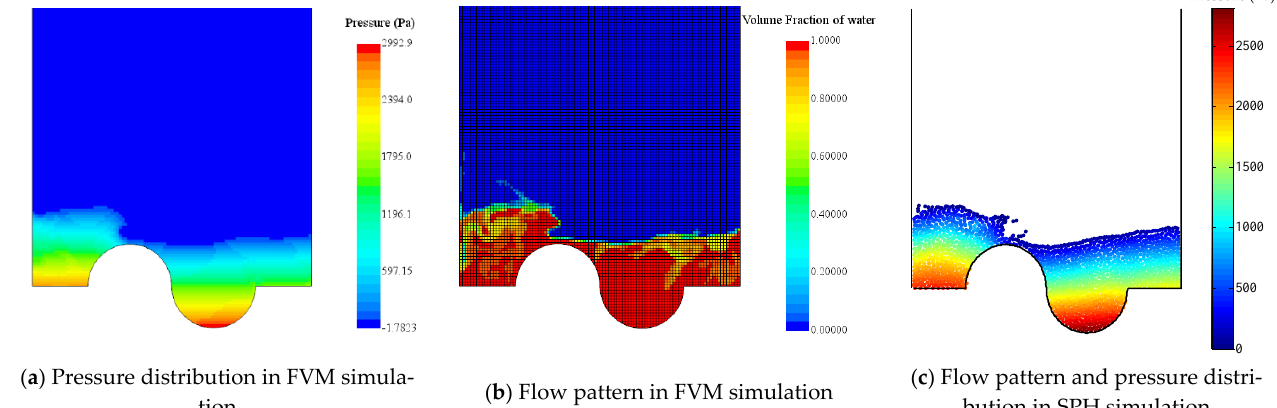
Figure 11. Comparisons of the flow pattern and pressure distribution at 10.0 s: ( a ) Pressure distribution in FVM simulation; ( b ) Flow pattern in FVM simulation; ( c) Flow pattern and pressure distribution in SPH simulation.